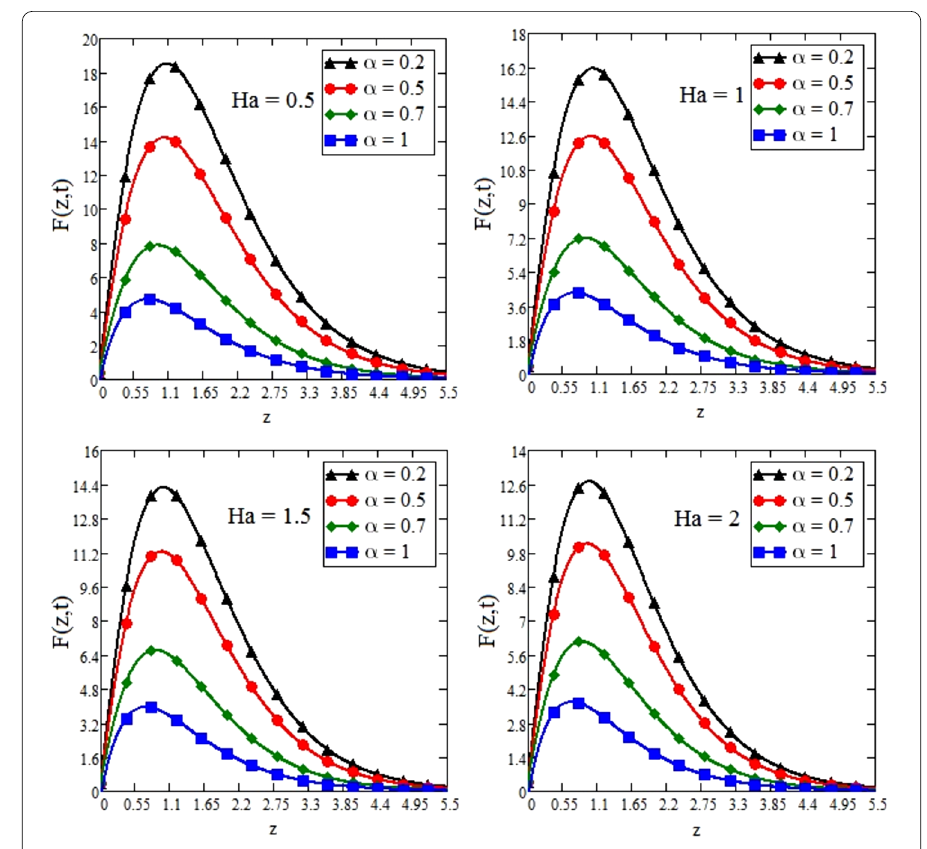
Figure 3 Impact of Ha on the velocity distribution of Jeffrey